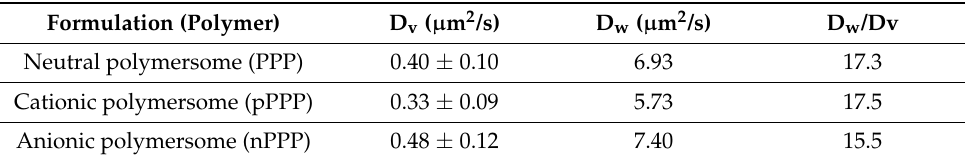
Table 2. Mobility parameters of polymersomes in the vitreous. D v was experimentally derived from single particle analysis based on mean square displacement of the particles, and D w was cal- culated using Stokes–Einstein equation.